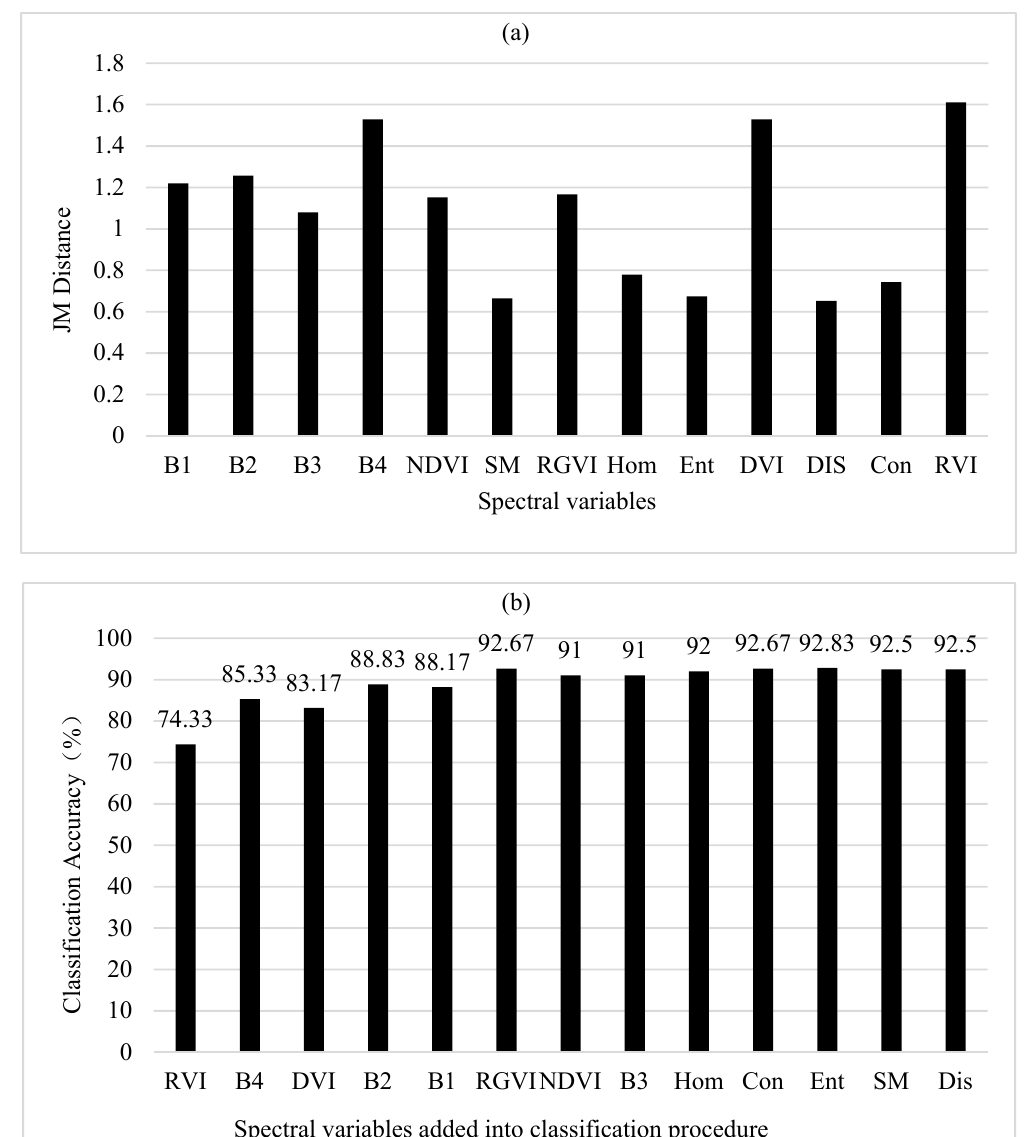
Figure 2. ( a ) Potential class separability of six land cover types for each spectral variable; and ( b ) the classification accuracies of Bayesian discriminant ( BD ) classifier as the spectral variables were added based on average Jeffreys–Matusita ( JM ) distances from large to small.